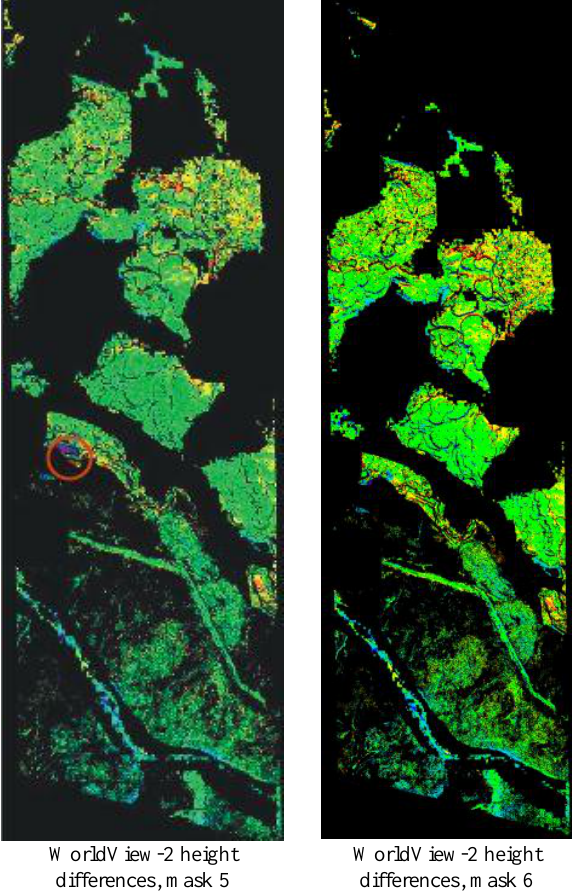
Figure 21. Color coded height differences for non-forest area with different forest masks – different area encircled The justification of the determination of systematic discrepancies as function of X and Y for just 30 groups and the smoothing filter is demonstrated by figures 19 and 20, showing the systematic discrepancies computed for 180 groups. Of course this supports the information about satellite jitter